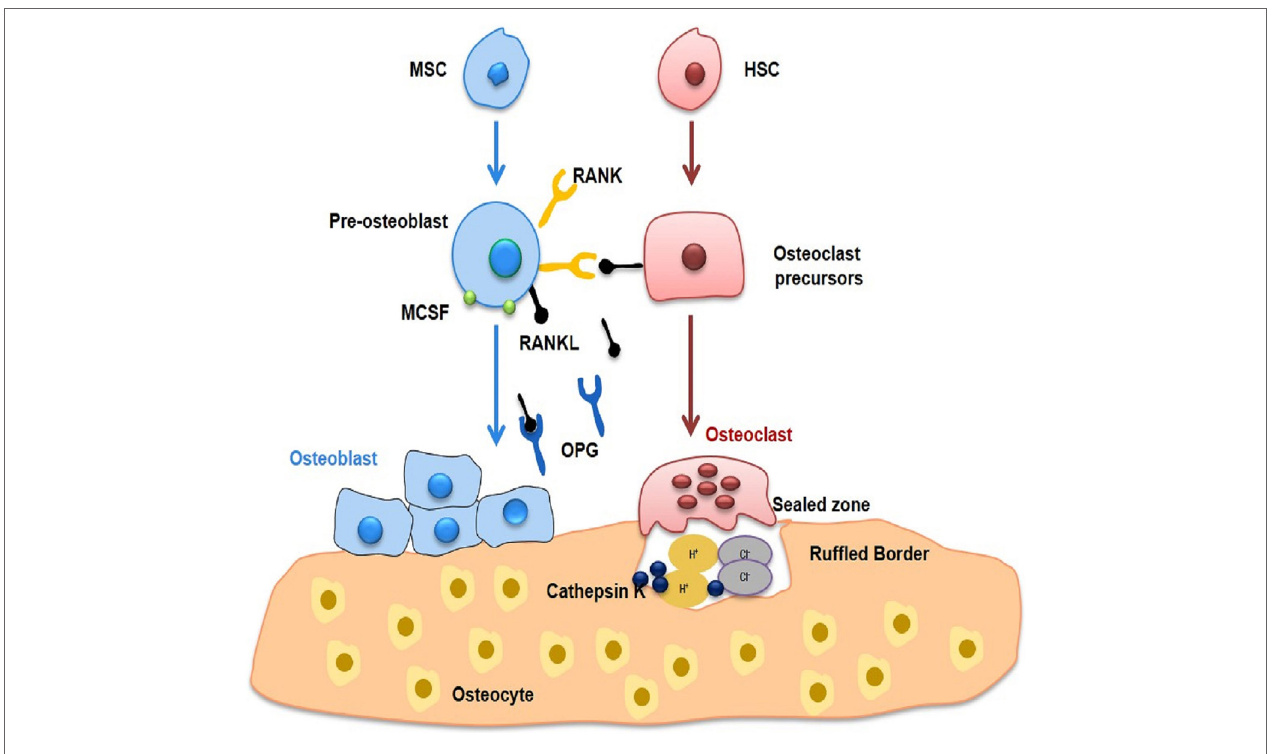
FigURe 1 | Bone remodelling. Bone undergoes continuous remodelling as a result of interaction between bone-forming osteoblasts and bone-resorbing osteoclasts. Both osteoclasts and osteoblasts lead to fine tuning of osteocytes, which in turn modulates remodelling. Osteoblasts are derivatives of MSCs and produce extracellular bone matrix of type I collagen and non-collagenous proteins, including osteocalcin, osteonectin, and osteopontin. Multinucleated osteoclasts are produced as a result of differentiation of macrophages and monocytes. RANKL in the presence of MCSF is primarily responsible for functioning and activation of osteoclasts leading to bone loss. On the other hand, osteoblasts produce OPG, which inhibits bone loss by inhibiting osteoclastogenesis. MSC, Mesenchymal stem cell; HSC, Hematopoietic stem cell; RANKL, Receptor activator for nuclear factor kappa; OPG,